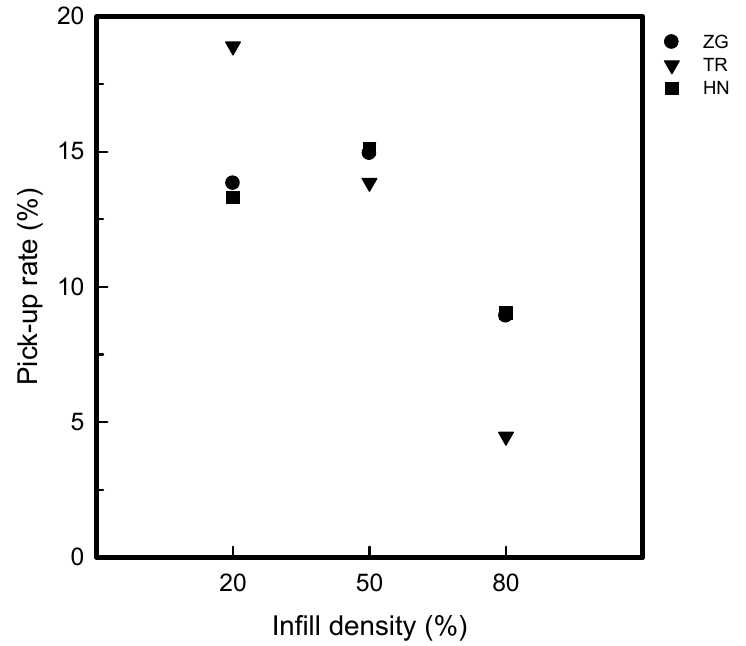
Figure 3. The pick-up rate of 3DP index fi ngertips with various in fi ll pa tt erns and